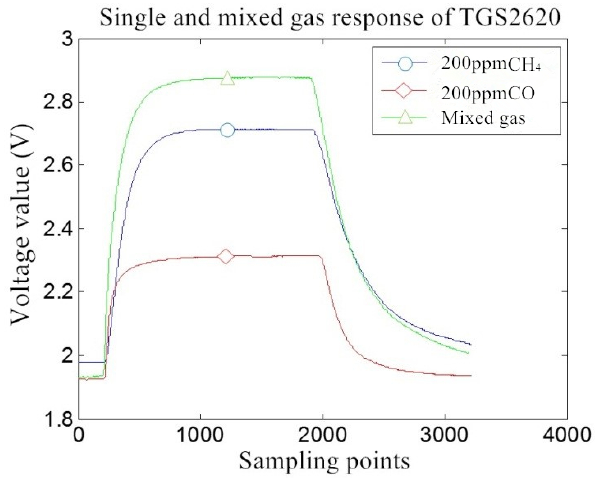
Figure 5. The response process curve of a single and mixed gas of the TGS2620 sensor.